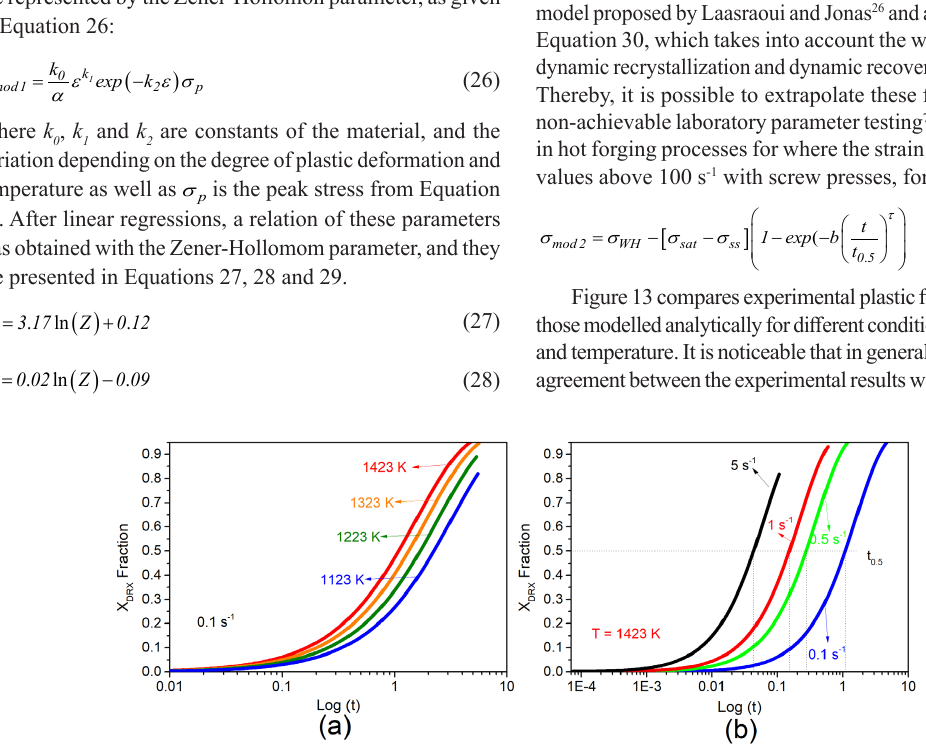
volume fraction of recrystallized grains during the hot working condition as a function of (a) Temperature, (b) Strain rate. Figure 12. X DRX